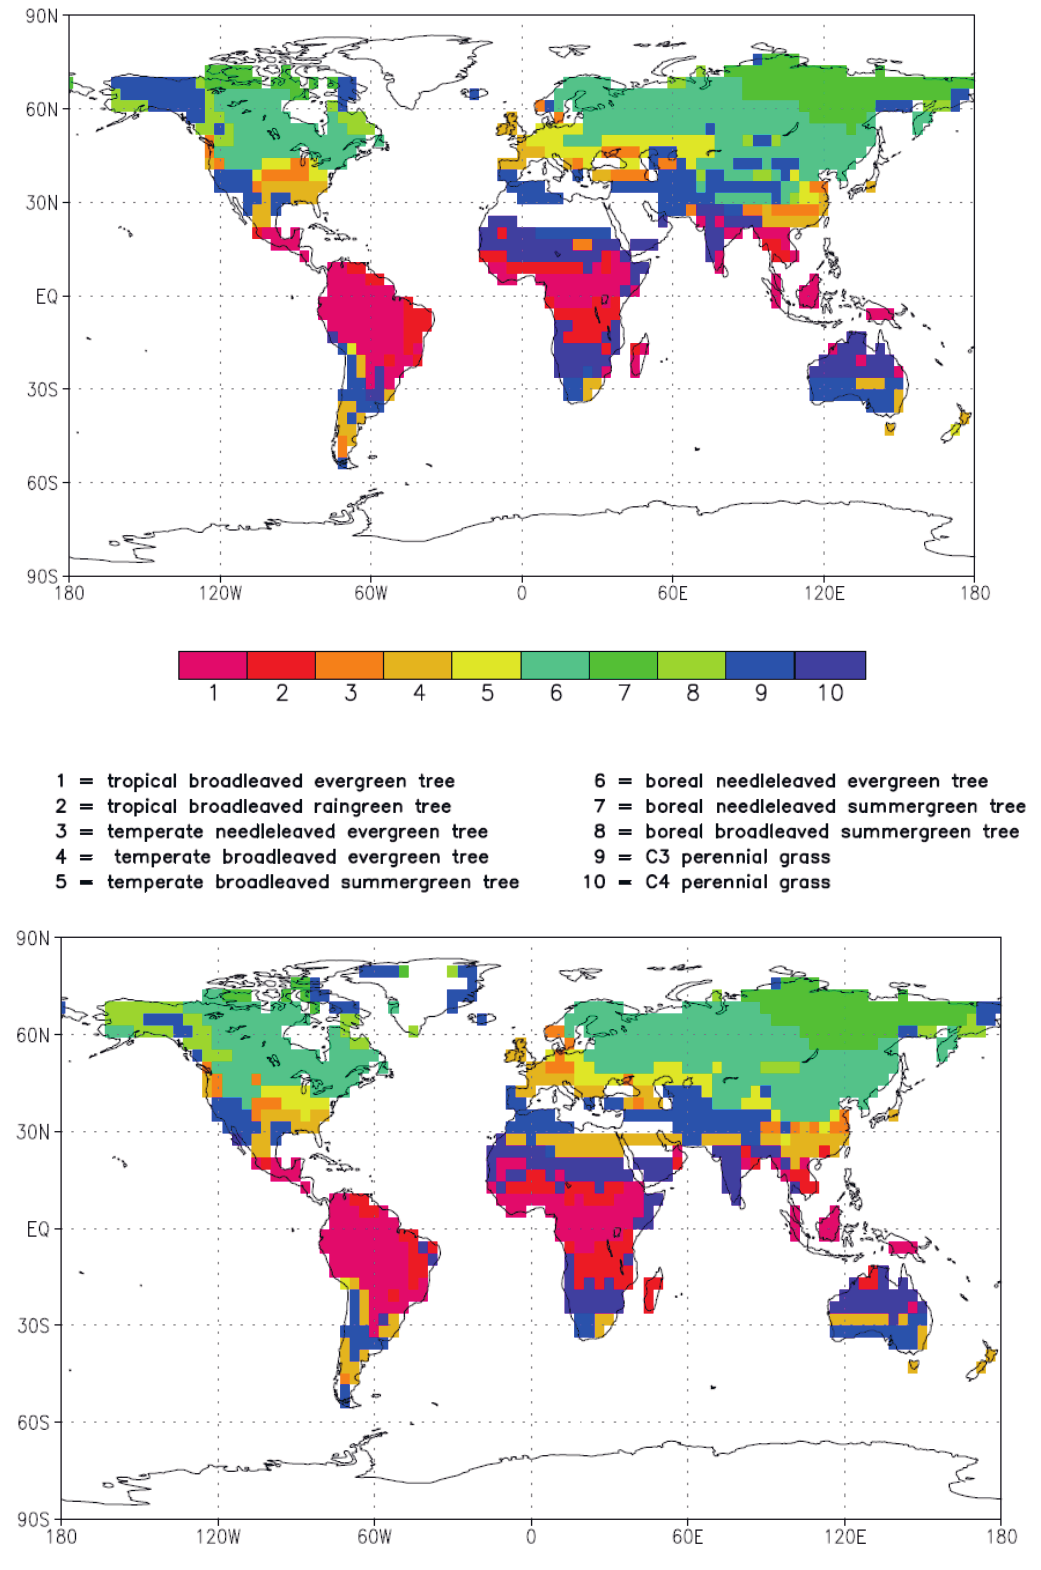
Figure 2. Dominant plant functional types as simulated by the LPJ dynamical vegetation model for present (upper panel) and Tortonian conditions (lower panel). The model has been run to equilibrium conditions (see text for details). White areas indicate regions with no